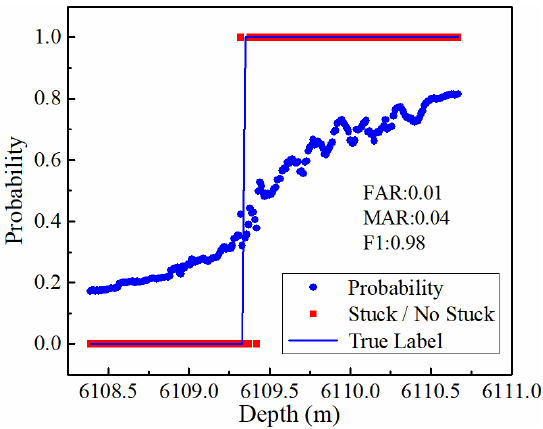
Figure 12. Prediction of stuck by comprehensive evaluation index.